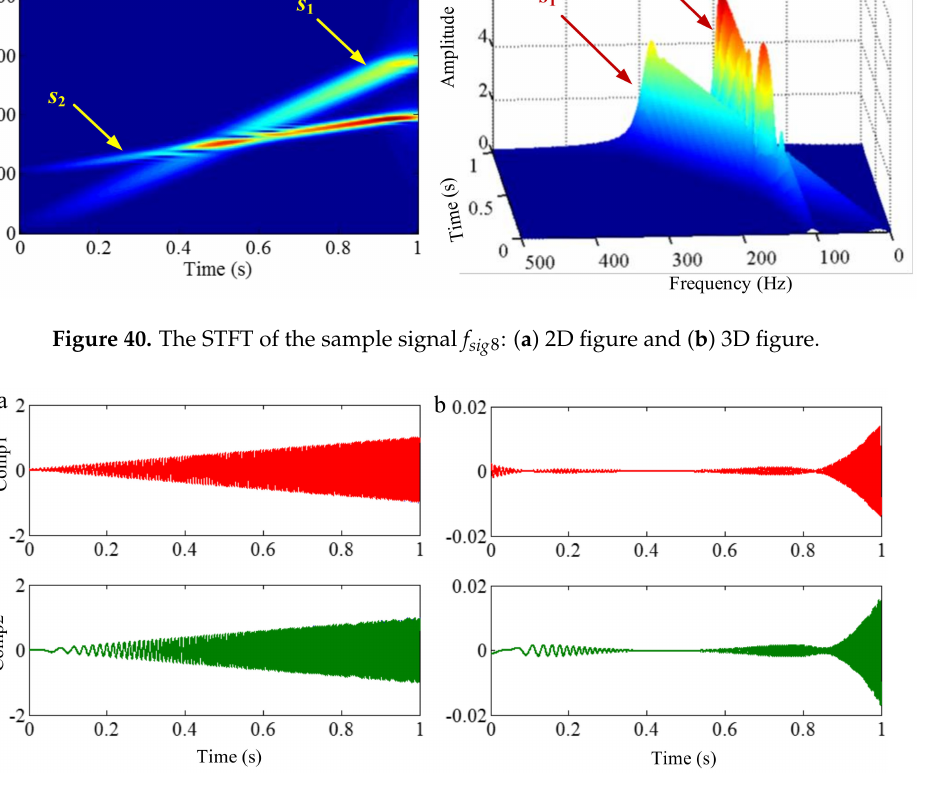
Figure 41. The waveforms of decomposition result of f sig 8 by using VKF_OT and the corresponding calculation errors: ( a ) waveforms and ( b ) calculation